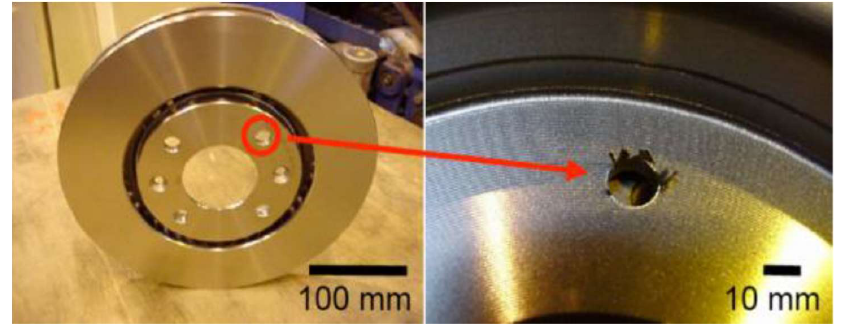
Fig. 1. Micro image of burr formation on Flange (2)